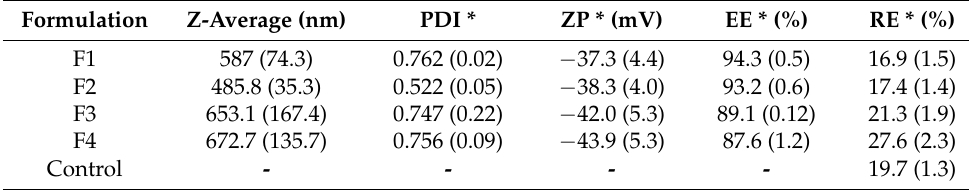
Table 2. The recorded characteristics of the tested formulations.